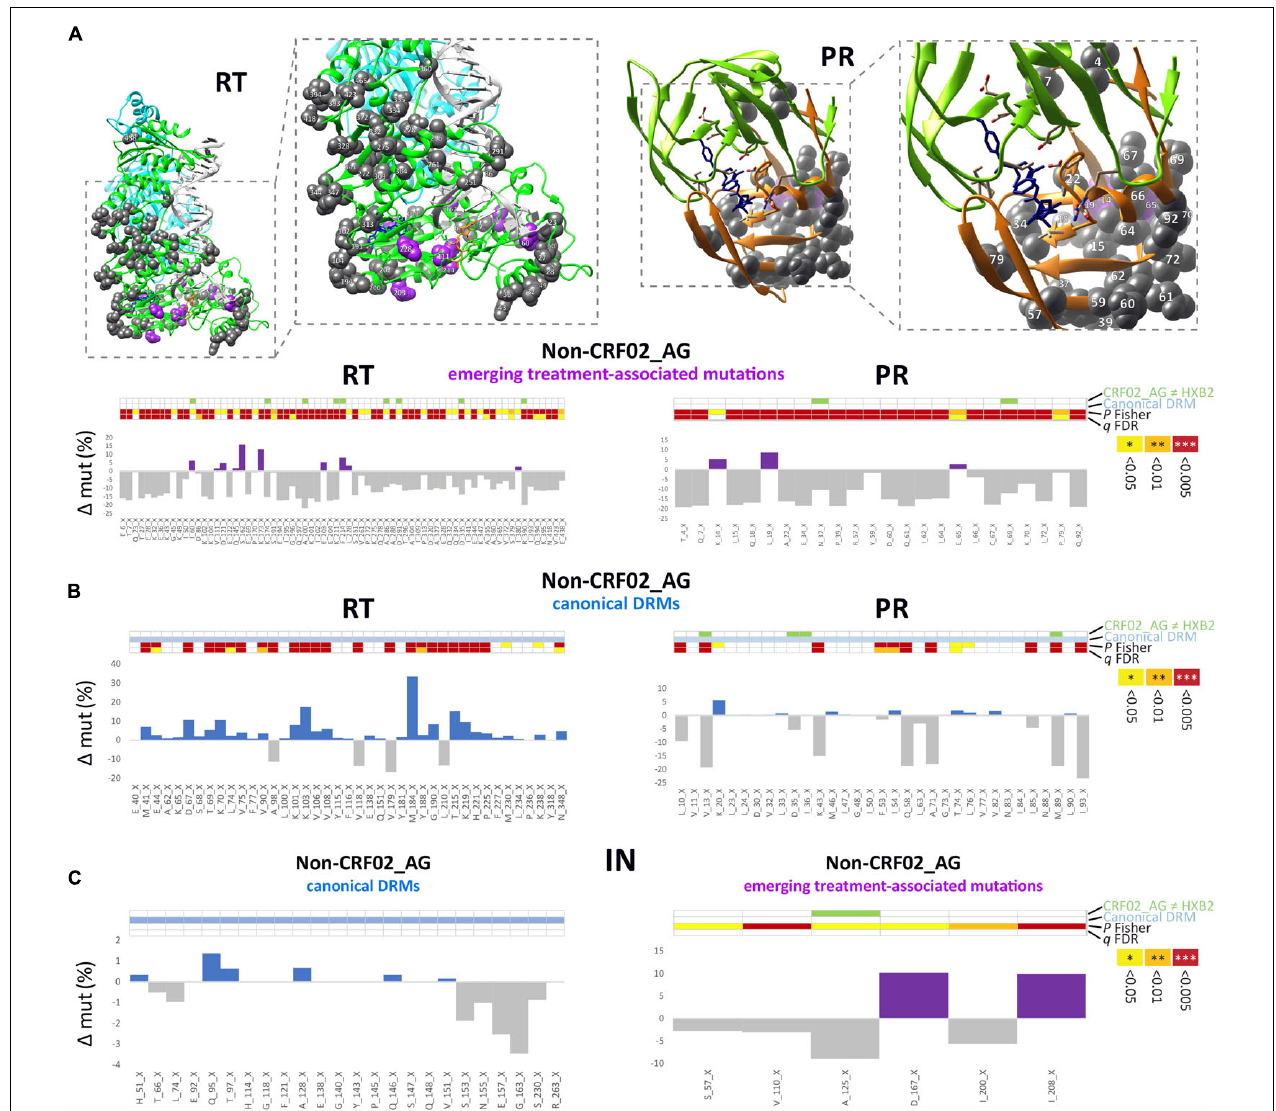
FIGURE 7 | Structural and statistical analysis of emerging mutations in Non-CRF02_AG. (A) Sites of significantly increasing or decreasing (P Fisher < 0.05) treatment-associated mutations in RT (left) and PR (right) are projected onto RT and PR structures. Calculations of site-specific mutation increases/decreases in Non-CRF02_AG between pre- and post-cART periods are shown below. Detailed views of the drug-binding regions with annotated aa sites are shown in boxes to the right. Treatment-associated mutation residues are displayed as magenta or gray spheres, according to a significant increase or decrease from pre- to post-cART, respectively ( P < 0.05). (B) Calculation of site-specific mutation differences in Non-CRF02_AG for canonical DRM sites. Bars are displayed in blue or gray according to a significant increase or decrease from pre- to post-cART, respectively ( P < 0.05). (C) Calculation of site-specific mutation differences in Non-CRF02_AG for the IN region, both for canonical DRM sites (left) and emerging treatment-associated mutations (right). The 4-row color strips indicate differences between CRF02_AG consensus sequences and HXB2 (green), sites of canonical drug resistance mut (DRM) sites (blue), and statistically significant mutation differences between pre- and post-cART periods in Fisher Exact tests (P values) and false discovery rates (FDR, q values), according to the legend to the